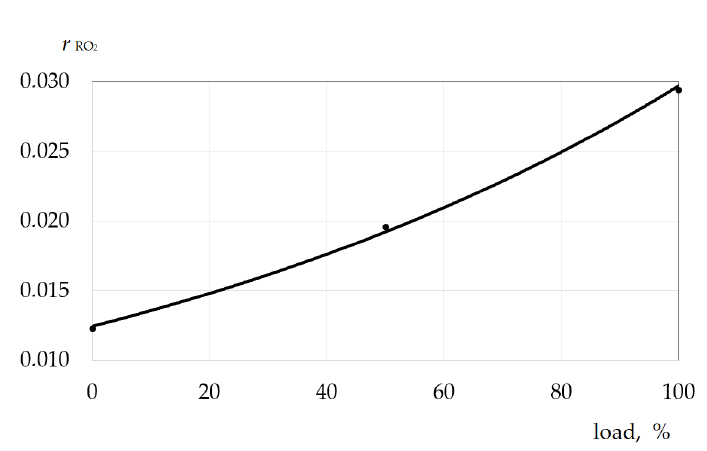
Figure 7. Dependence of mass fraction of triatomic gases on the load value.